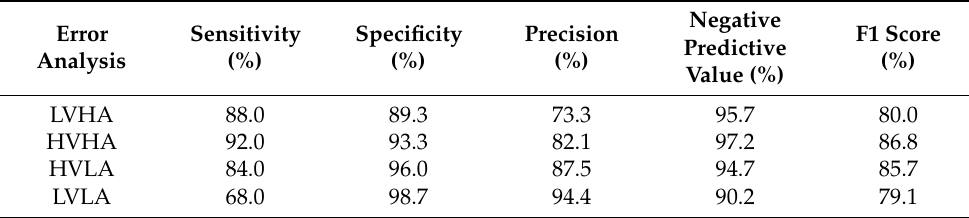
Table 5. The error analysis for results obtained using three classifiers.